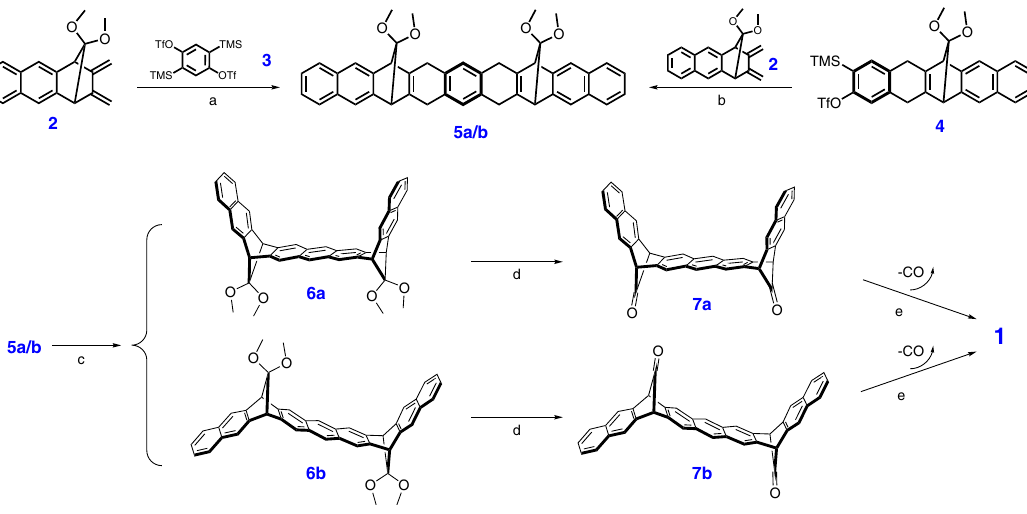
Fig. 3 Synthesis of nonacene 1. a CsF, acetonitrile/THF (4:1), room temperature, 16 h., 62% (anti : syn 1:2); b CsF, acetonitrile/THF (5:1), room temperature, 16 h., 98% (anti : syn 1:2); c DDQ, toluene, room temperature, 4 h. 94%; d TMSI, room temperature, 24 h., 94% for 7a and 48 h., 95% for 7b ; e neat 350 °C, 20 min., quant.